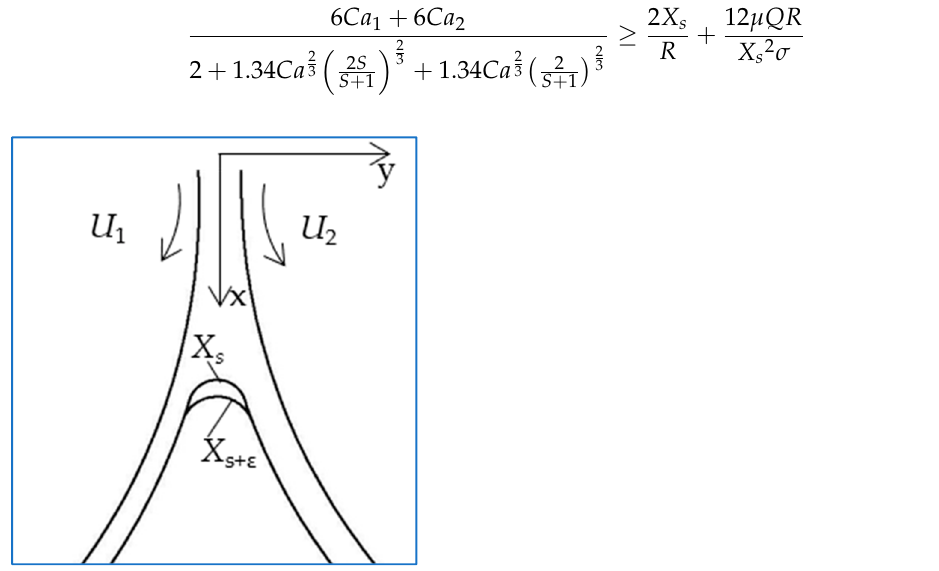
Figure 5. Variation diagram of the meniscus after introducing a small disturbance ε .